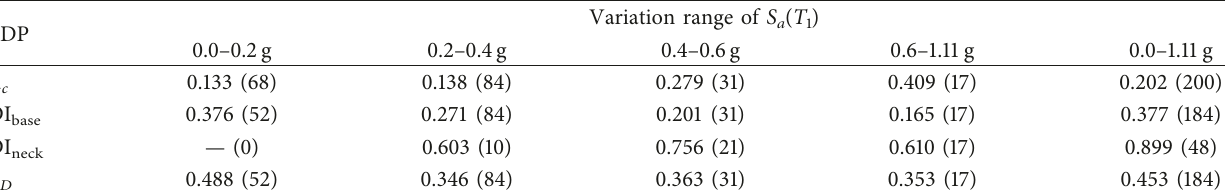
Table 3: Dispersion of EDP | IM for IM as various ranges of S a ( T 1 ). The numbers in parentheses show the number of earthquake records that cause nonzero response values in each group.